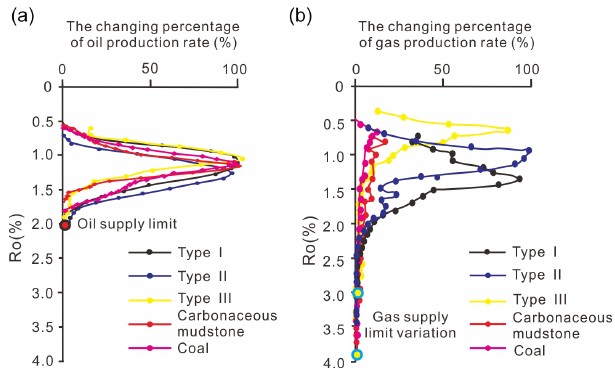
Figure 9. Investigation of ASDLs for different hydrocarbon types by high-temperature and high-pressure pyrolysis simulation. (a) The variation in oil production rate with Ro and identification of ASDLo. (b) The variation in gas production rate with Ro and identification of